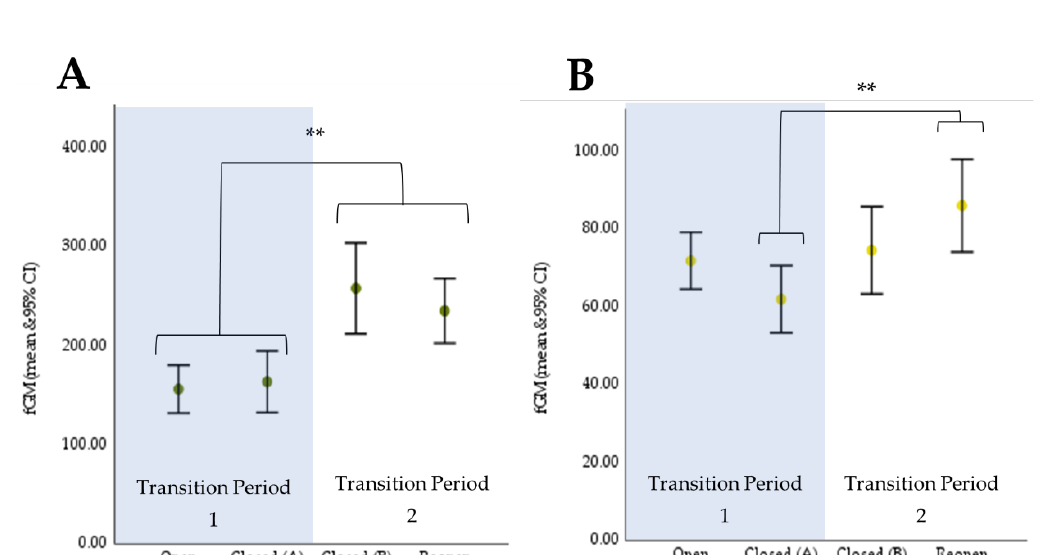
Figure 2. Results from repeated measures mixed 2-way ANOVA models. Asterisks (**) indicate significance at α = 0.90. Data are back transformed from log-transformed data. Error bars are 95% CI. ( A ) Average cheetah fGM concentrations. ( B ) Average giraffe fGM concentrations.